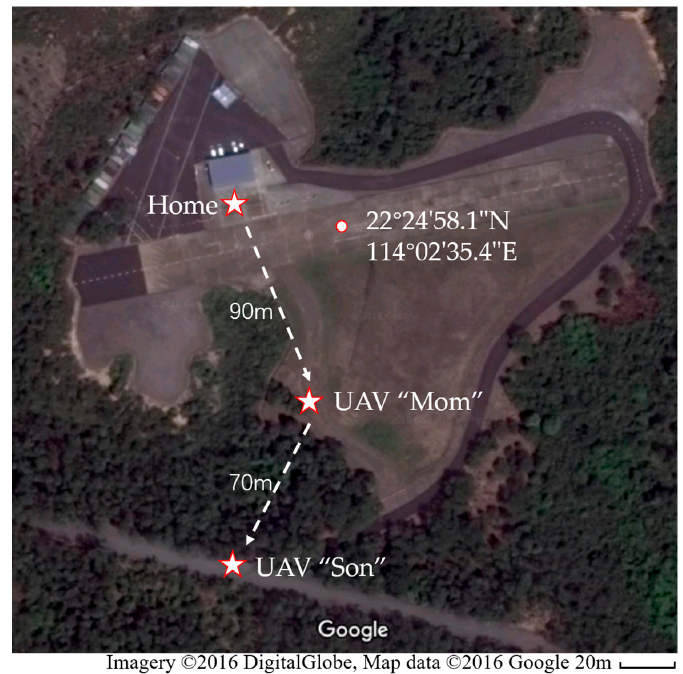
Figure 16. Final positions of nodes in the Google map in the cross-obstacle tests test in Hong Kong.